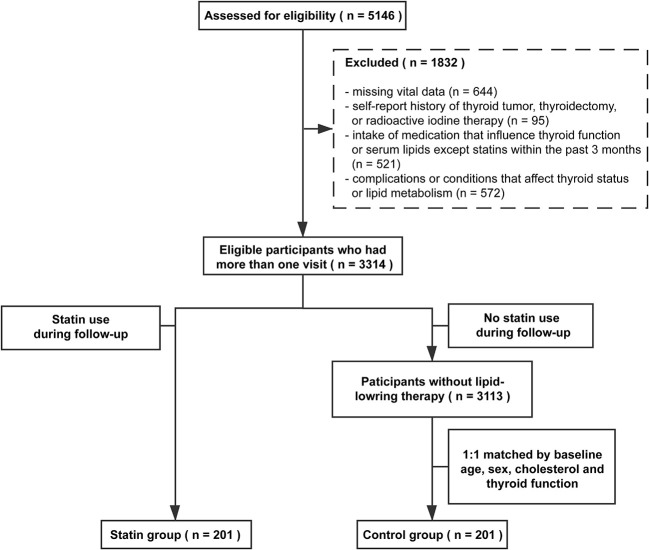
The flowchart of enrollment.